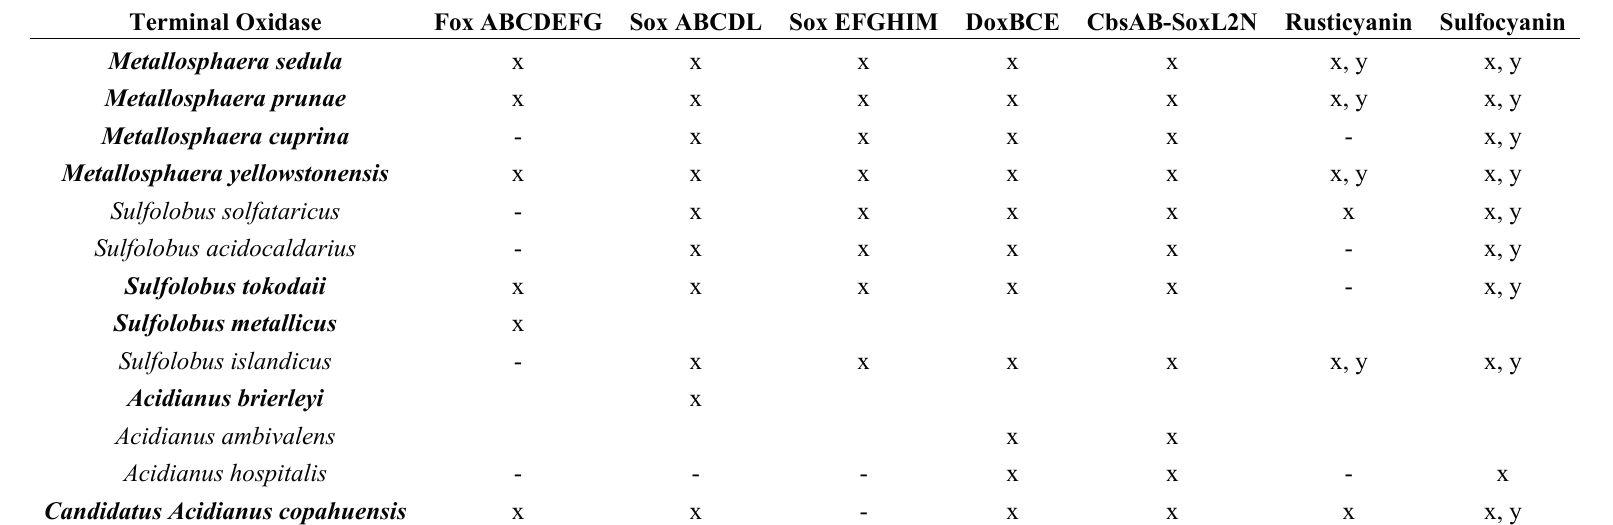
Table 2. Complete terminal oxidase clusters and associated proteins identifiable in sequenced extreme thermoacidophile genomes. (x) and (-) indicate presence and absence, respectively, with (y) being used when a secondary candidate exists. Species in bold are known to oxidize Fe(II). Blank boxes indicate absence of sequence data for those species. Homology searches were completed using previously identified M. sedula proteins as search queries with The National Center for Biotechnology Information’s (NCBI) Basic Local Alignment Search Tool (BLAST) against the Sulfolobales (taxid:2281)